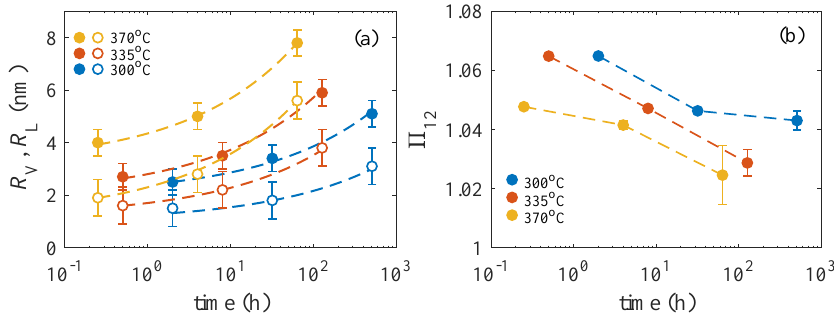
Figure 8. ( a ) Vertical ( R V , full) and lateral radii ( R L , open circles) of the ω particles determined from the detector images as functions of the ageing time t and temperatures. The dashed lines are the t 1/3 fits following from the LSW model. ( b ) The ratio Π 12 of the intensities measured at samples aged at various times and temperatures.